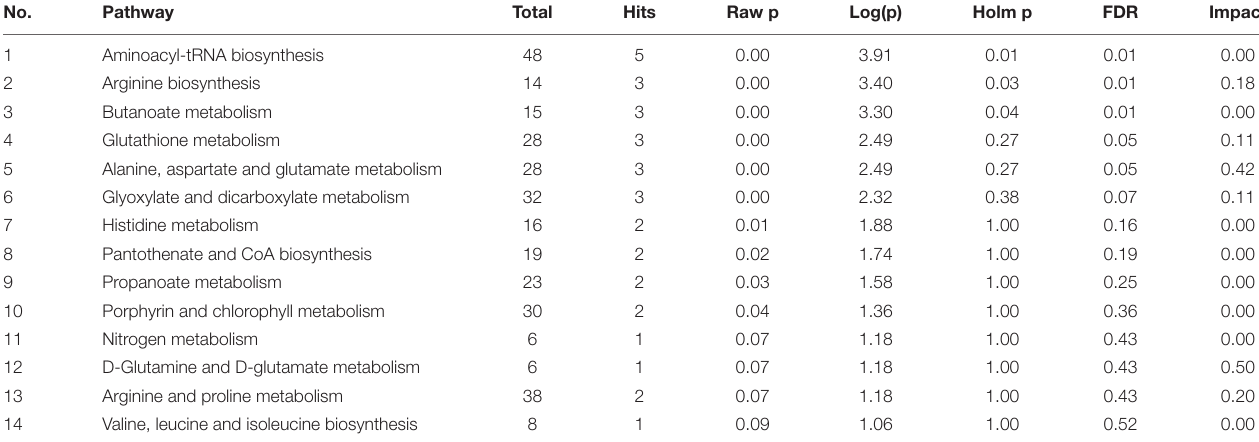
TABLE 2 | Metabolite